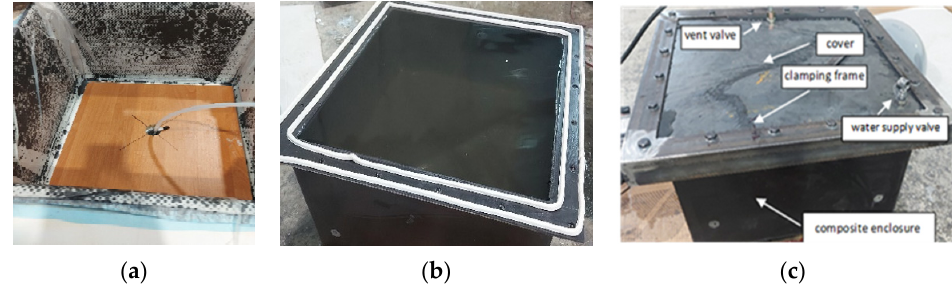
Figure 18. Enclosure physical model. Technology ( a ), seal ( b ) prepared enclosure for testing ( c ). The test stand (Figure 19) consisted of a water tank, an IBO PR-AUTO pump with a capacity of 174 l min, maximum pressure of 60 bar, equipped with a manometer, filtering system, and supply hoses (IBO, Ferrara, Italy).